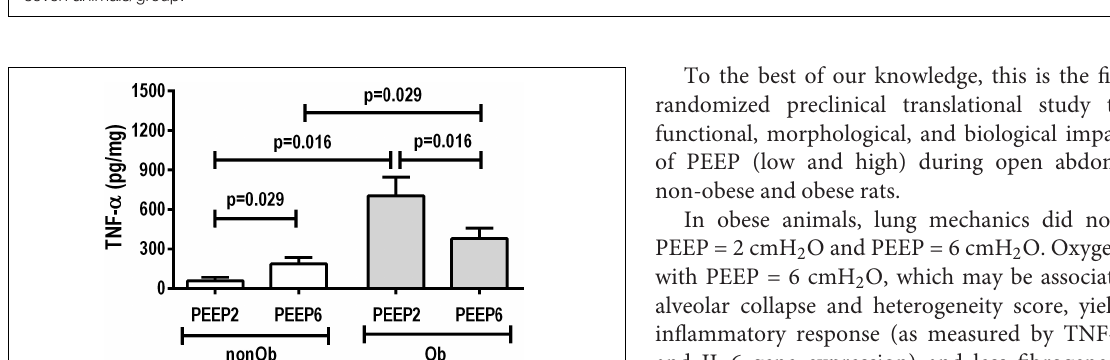
FIGURE 3 | Expression of biologic markers associated with lung damage in non-obese (nonOb) and obese (Ob) mechanically ventilated groups. Low-PEEP (2 cmH 2 O) and High-PEEP (6 cmH 2 O). Real-time polymerase chain reaction analysis of interleukin (IL)-6 and type III procollagen (PCIII). Relative gene expression was calculated as a ratio of average expression of each gene to the reference gene ( 36B4 ) and expressed as fold change relative to non-ventilated animals (NV). Boxes show the interquartile range (25th–75th percentile), while whiskers encompass the range (minimum-maximum) and horizontal lines represent the median in seven animals/group.